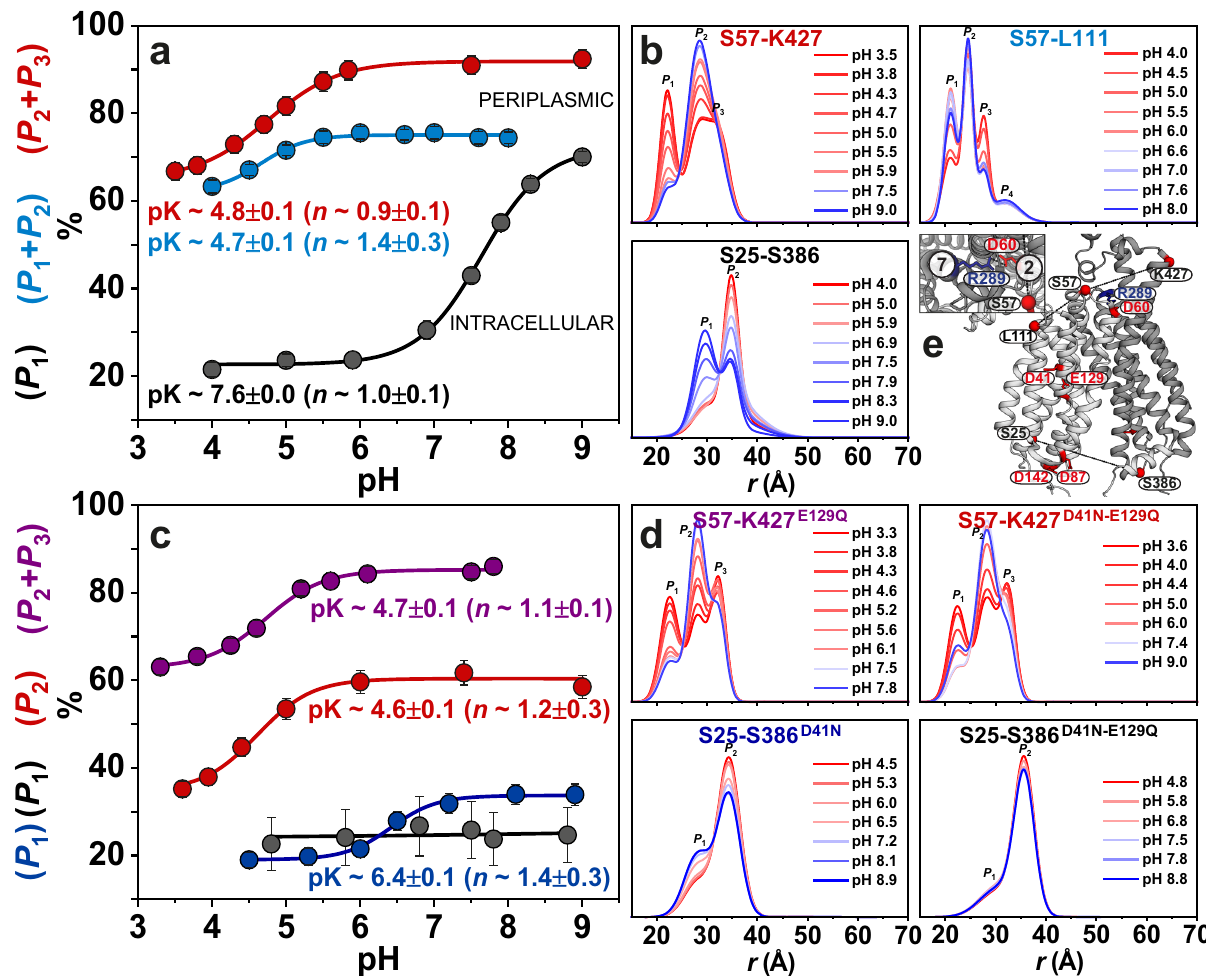
Fig. 8 | Intracellular and periplasmic sides of Hn Spns sense its protonation statedifferently.a , b Distancedistributionsofperiplasmic(S57-K427andS57-L111) andintracellular(S25-S386)pairsobtainedatdifferentpHvaluesinlipidnanodiscs (Supplementary Fig. 11) and LMNG micelles (Supplementary Fig. 12). The variation in the population of rising or decreasing distance peaks as a function of pH was used to estimate the pK value for conformational changes in Hn Spns on either membrane side. c , d Effect of protonation-mimetic mutation of acidic residues on pK values for conformational changes. The D41N-E129Q double mutation